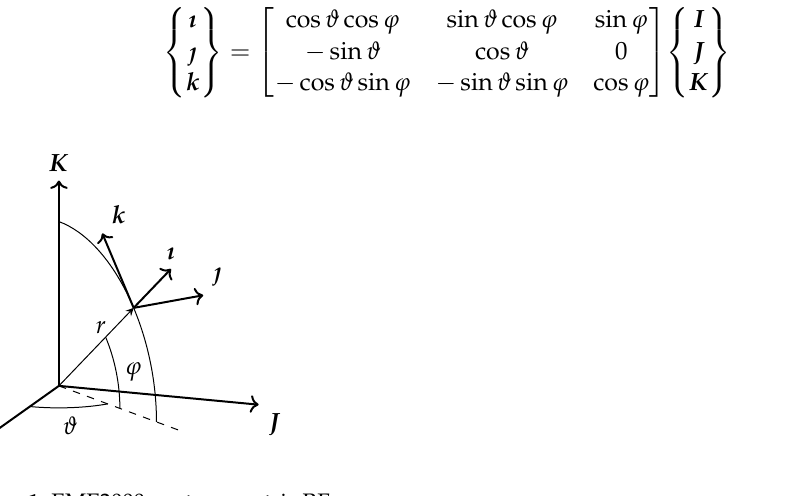
Figure 1. EME2000 vs. topocentric